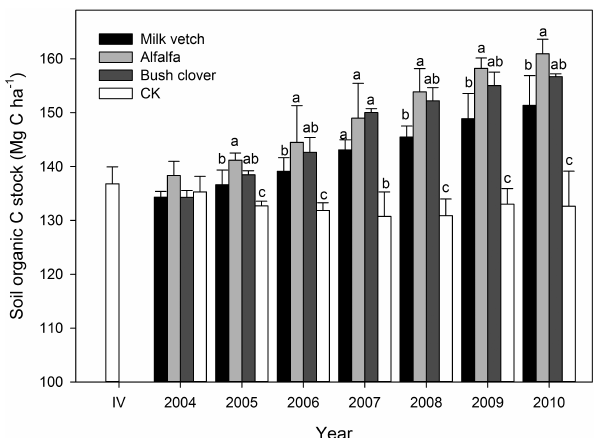
Figure 5. Change in soil organic carbon amount (stock) in different soil layers under milk vetch, alfalfa, bush clover and bare soil (CK) from May 2004 to October 2010. Different letters indicate signifi- cant differences ( P <0.05) between total carbon